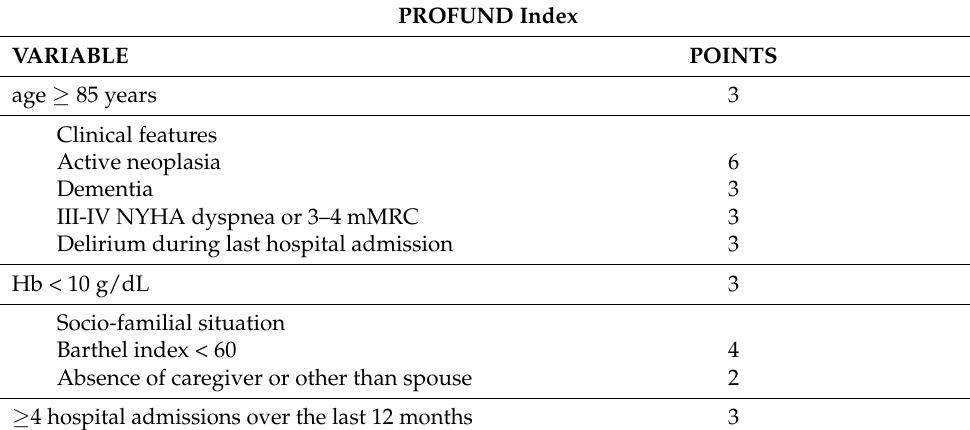
Table 1. PROFUND index. Clinical variables included and scoring of these